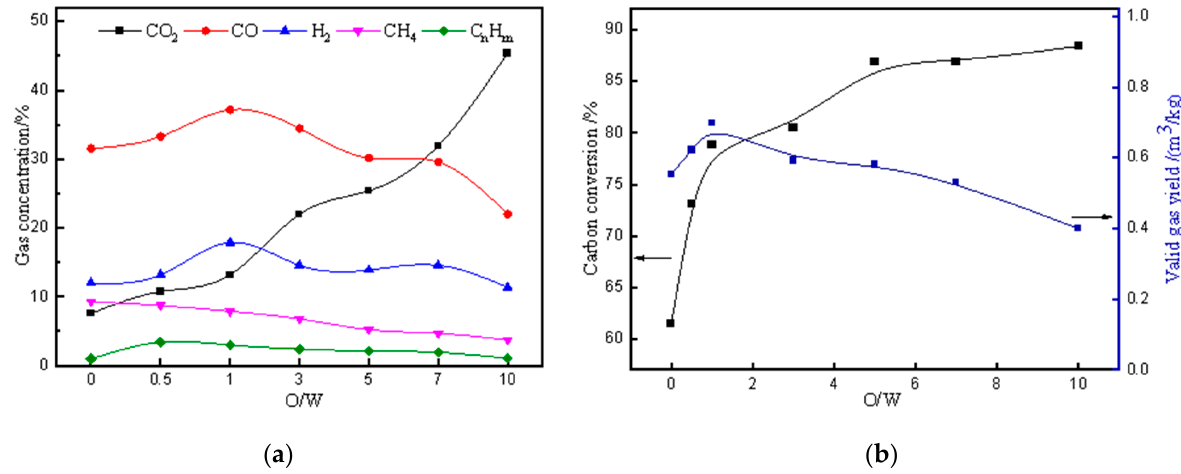
Figure 5. The effects of the O/W ratio upon ( a ) the gas concentrations and ( b ) the carbon conversion (black) and valid gas yield (blue) during wood waste gasification using the Ni-O modified hematite.